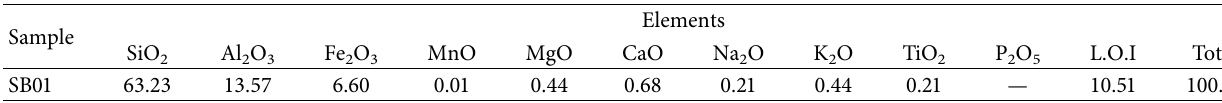
Table 7: Composition in oxides of Sabga clay.